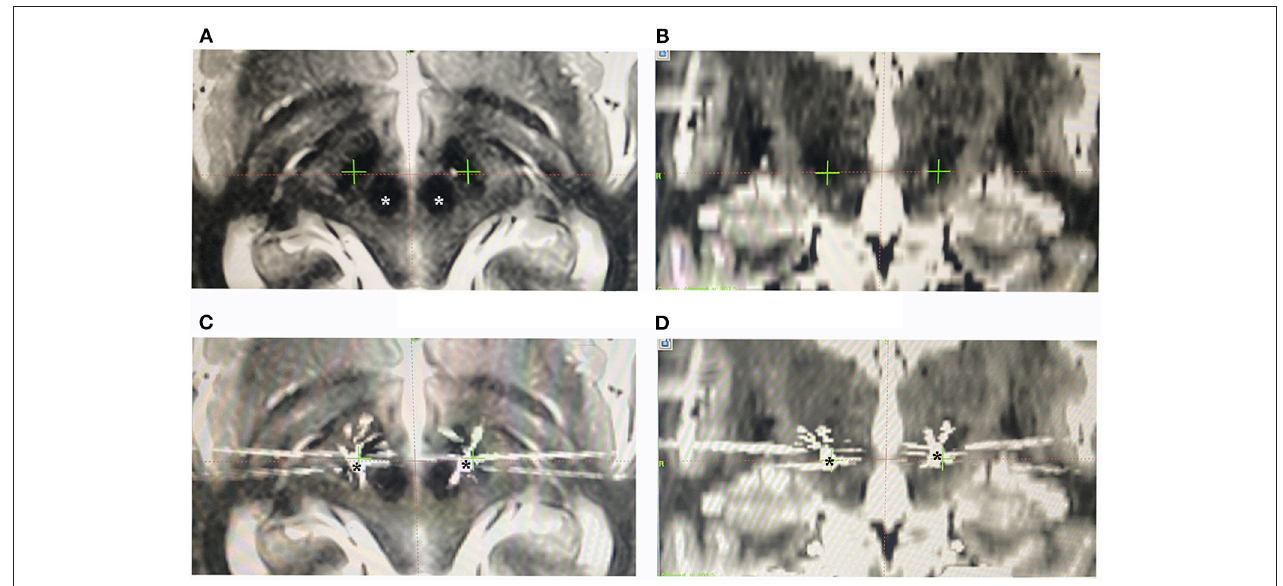
FIGURE 2 | Preoperative planning for lead implantation and postoperative verification of the lead location. (A,B) , Preoperative planning on MRI images using the SurgiPlan software, with the targets (green crosses) placed along the anterior edge of the red nucleus (white asterisk). (C,D) Postoperative verification of the lead location (black asterisk) using the SurgiPlan software to overlap postoperative CT images onto preoperative MRI images.